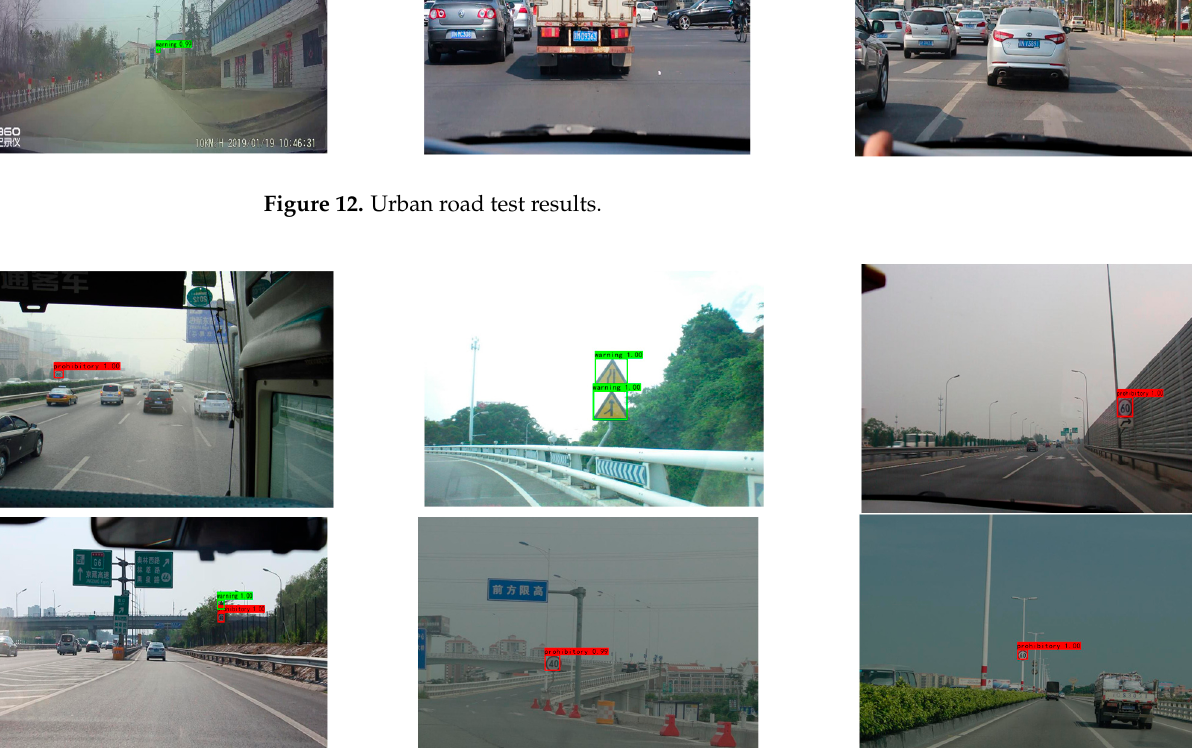
Figure 13. Highway test results.